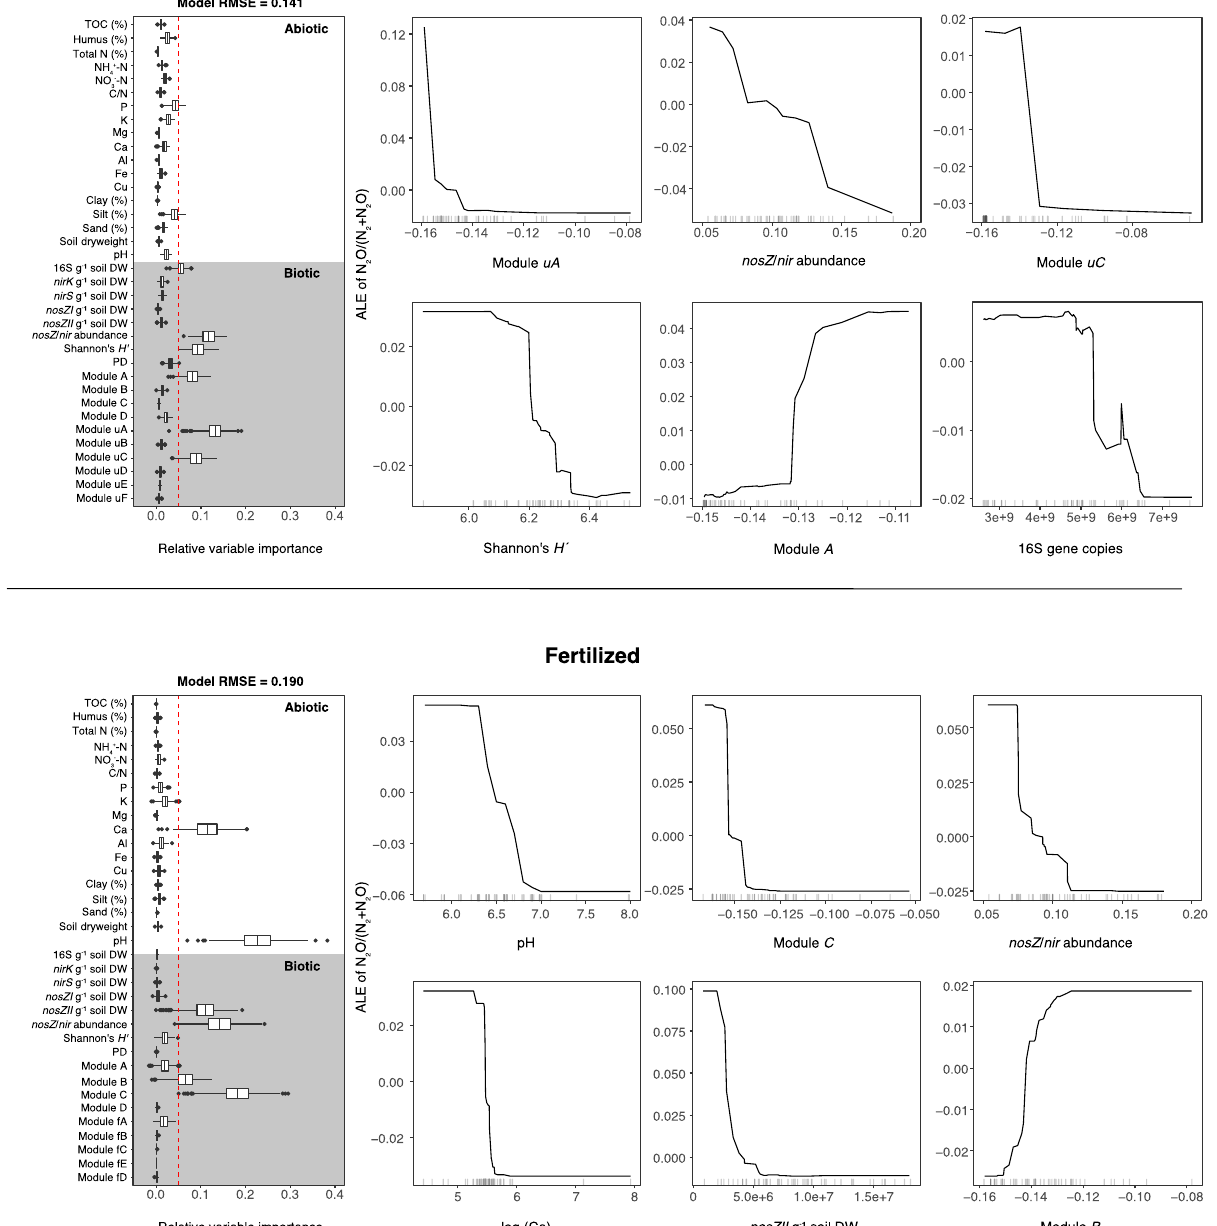
Fig. 4 Relative importance of abiotic and biotic factors in predicting denitri fi cation end-product ratios (N 2 O/[N 2 + N 2 O]) in fertilized and unfertilized soils based on generalized boosted regression modelling. Model fi t is indicated by the residual mean squared error (RMSE) in the fi gure. Predictor variables with median relative permutation importance ( n = 500 permutations) >5% were used to generate accumulated local effects (ALE) plots, which show the relationship between the predictor variables ( x -axis) and end-product ratios in the model ( y -axis) while accounting for potential correlations amongst predictor values. Note that the scale of the end-product response in the y -axis is normalized in ALE plots based on the conditional response within a range of the predictor value. For boxplots, box limits represent the inter-quartile range (IQR) with median values represented by the centreline. Whiskers represent values ≤ 1.5 times the upper and lower quartiles, while points indicate values outside this